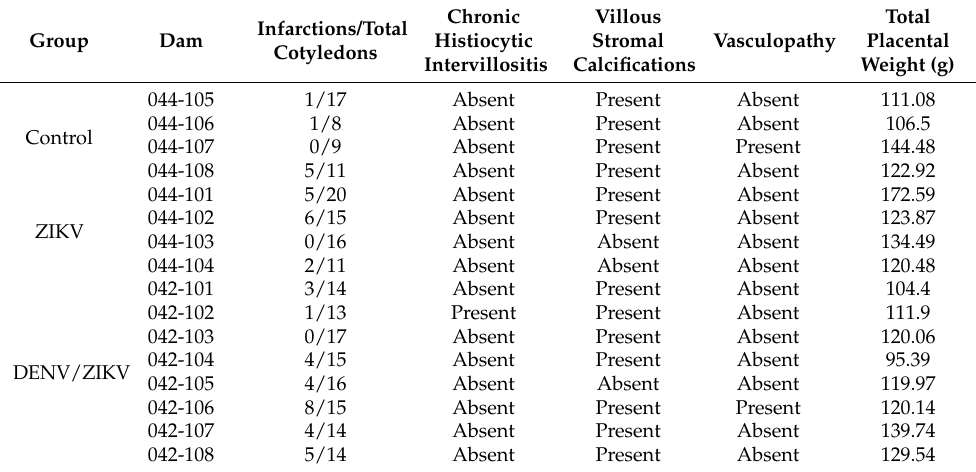
Figure 5. Fetal growth parameter trajectories for ZIKV-exposed, DENV/ZIKV-exposed and control fetuses. Fetal growth parameters throughout gestation were calculated as Z scores relative to age-matched fetal macaque parameters [21] and graphically represented as a linear trajectory. Fetal head circumference growth trajectory is represented in ( A ), biparietal diameter in ( B ), femur length in ( C ), and abdominal circumference in ( D ). Table 2. Placental